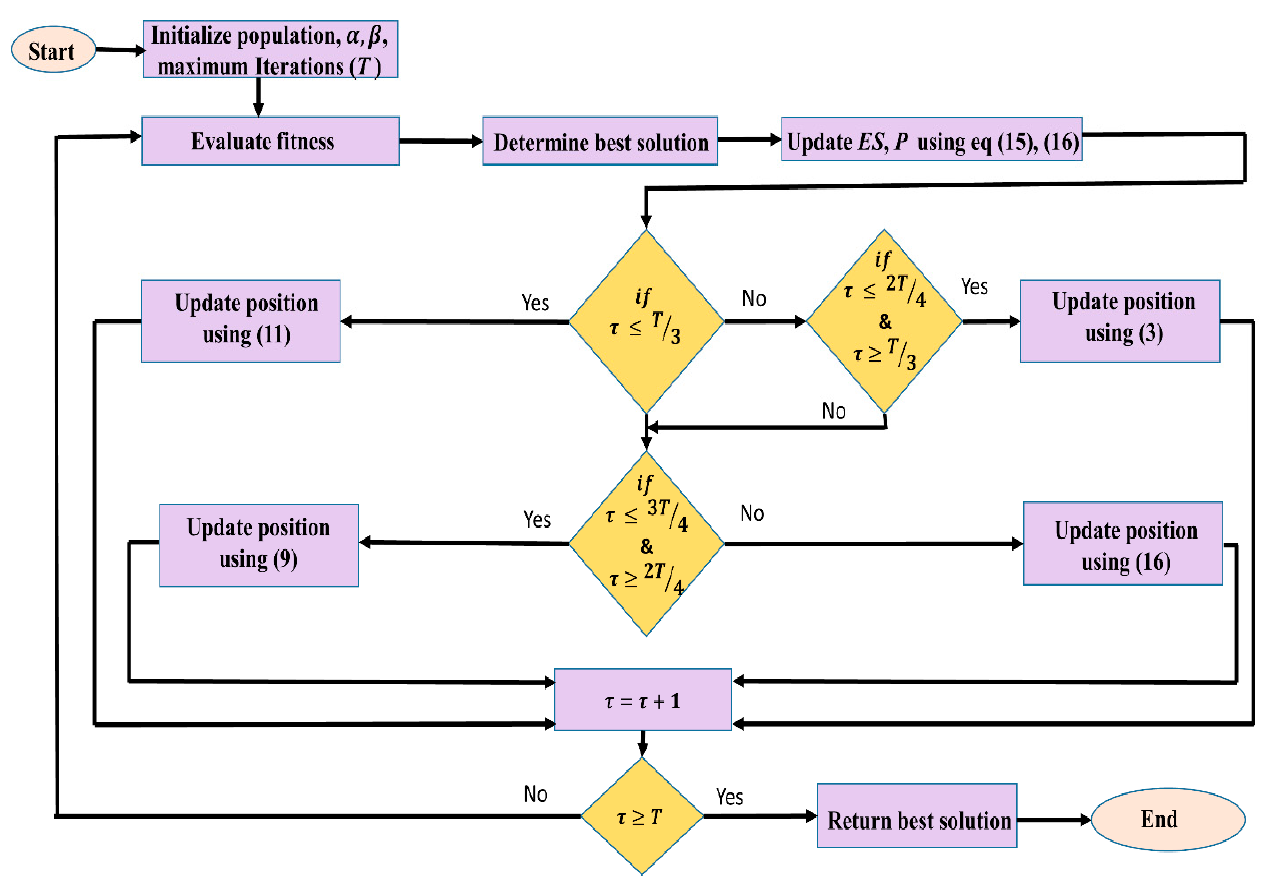
Figure 2. Flow chart of